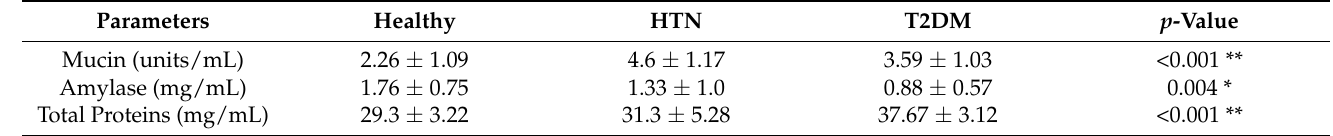
Table 2. Levels of mucin, amylase, and total proteins among the study groups.